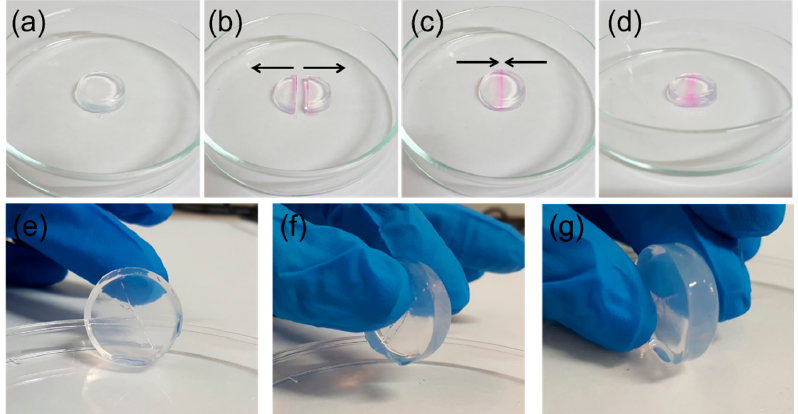
Figure 3. Self-healing properties in a free-standing, 0.7% agarose hydrogel cylinder. From ( a – c ): pristine hydrogel cylinder, cutting event with separation of the two halves, and reassembly of the two halves. ( d ) Self-healing waiting phase of the hydrogel. From ( e – g ): handling of the completely self-healed hydrogel